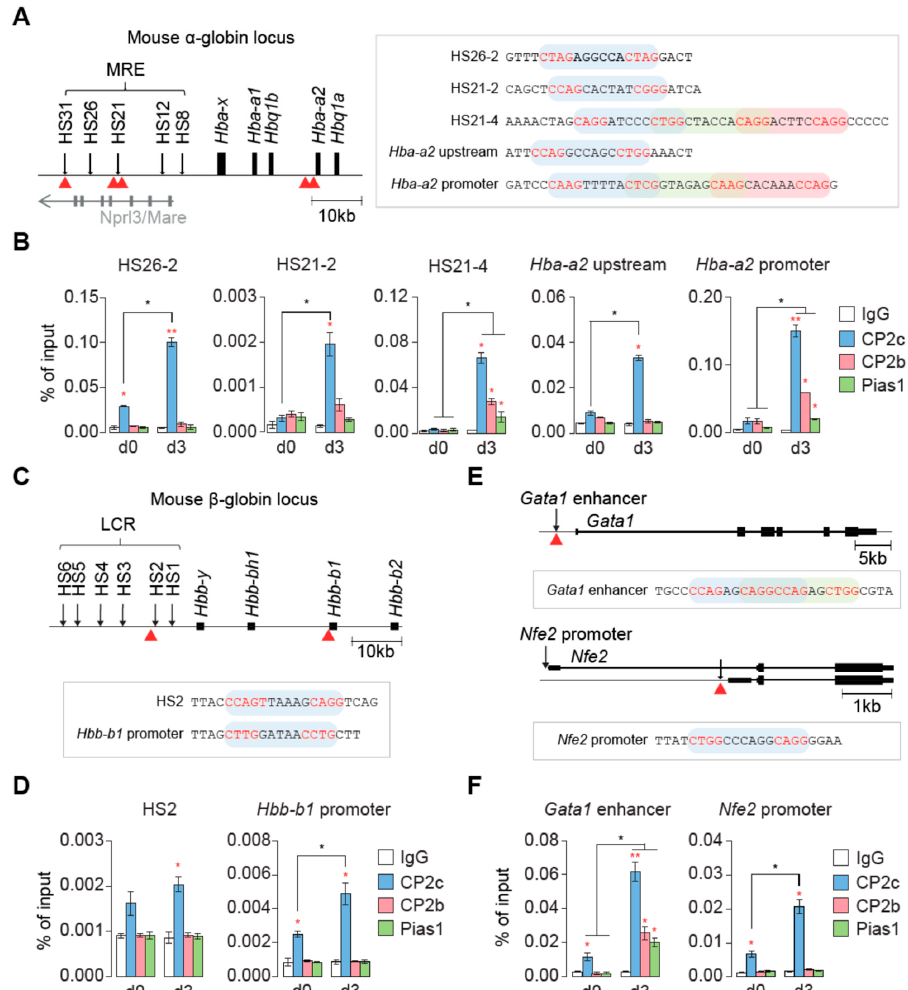
Figure 1. Differential binding of tCP2c and CBP to the erythroid gene regulatory regions in mouse erythroleukemia (MEL) cells. ( A , B ) Differential binding modes of CP2c complex proteins in the regulatory regions of the mouse α -globin locus. ( A ) Schematic representation of the mouse α -globin locus (left) and illustration of CP2c binding motifs in several regulatory regions (HS26, HS21, Hba-a2 upstream, and Hba-a2 promoter). ( B ) Chromatin immunoprecipitation (ChIP)-qPCR profiles of the CP2c complex proteins in uninduced (d0) and induced (differentiation day 3, d3) MEL cells. ( C , D ) Differential binding modes of CP2c complex proteins in the regulatory regions of the mouse β -globin locus. ( C ) Schematic representation of the mouse β -globin locus (left) and illustration of CP2c binding motifs in several regulatory regions (HS2 and Hbb-b1 promoter). ( D ) ChIP-qPCR profiles of the CP2c complex proteins in d0 and d3 MEL cells. ( E , F ) Differential binding modes of CP2c complex proteins in the Gata1 proximal enhancer and in the Nfe2 promoter regions. ( E ) Schematic representations of the Gata1 proximal enhancer and the Nfe2 promoter regions, illustrating their CP2c binding motifs. ( F ) ChIP-qPCR profiles of the CP2c complex proteins in d0 and d3 MEL cells. Data are means ± SD of two independent biological replicates. Asterisks indicate significant differences (Student’s t -test): ** p < 0.01; * p < 0.05.